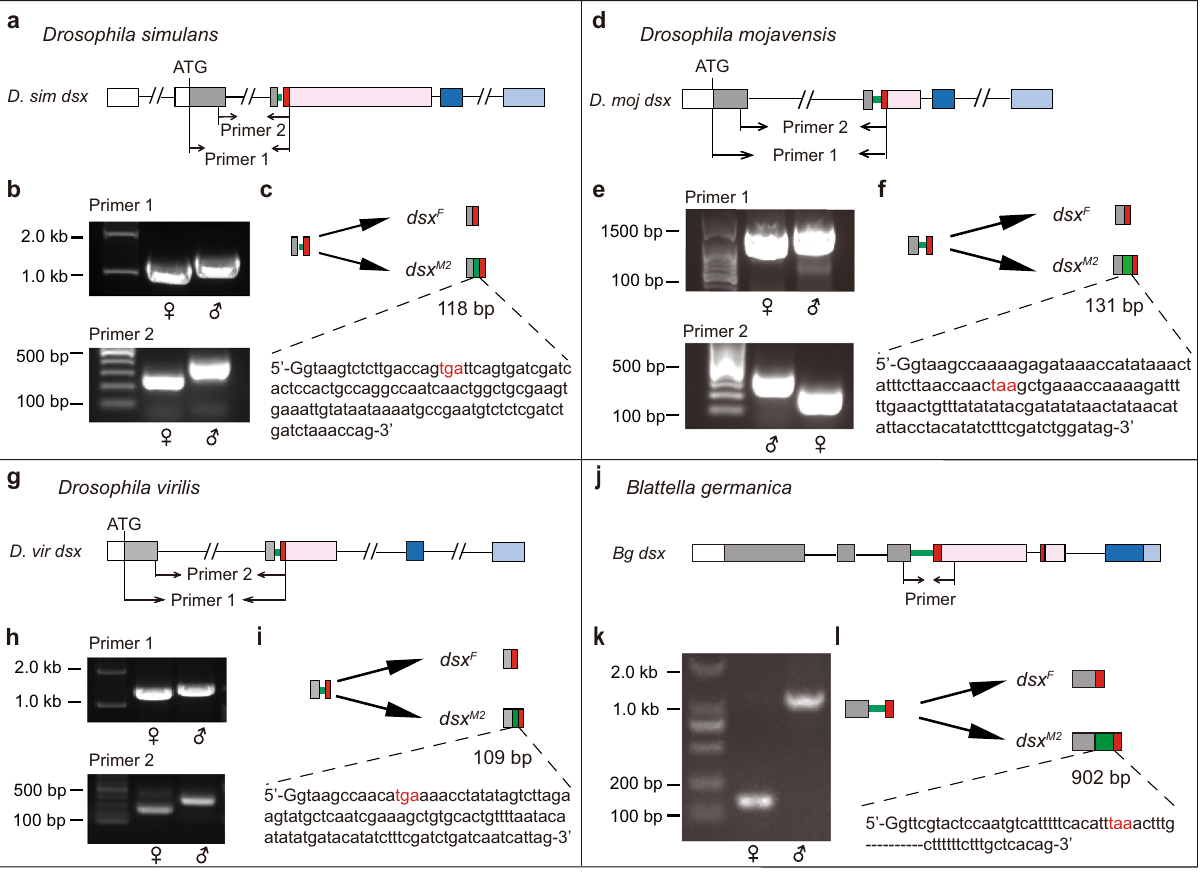
Fig. 3 Intron retention-induced sex-speci fi c splicing is widely conserved. Retention of the intron that separates the last common exon and the female- speci fi c exon generates male-speci fi c dsx M2 transcripts in D. simulans ( a – c ), D. mojavensis ( d – f ), D. virilis ( g – i ) and B. germanica ( j – l ). The dsx gene structures are illustrated in a , d , g and j . White and gray boxes indicate common 5 ’ -UTR and coding sequences respectively in both sexes. Red and pink boxes indicate coding and 3 ’ -UTR sequences of the female-speci fi c exon. Dark and light blue boxes indicate coding and 3 ’ -UTR sequences of male-speci fi c exons. The thick green line indicates the intron spliced out in the dsx F transcript and retained in the dsx M2 transcript. Primers for RT-PCR experiments ( b , e , h and k ) are indicated respectively ( a , d , g and j ). Full sequences of the retained intron of dsx M2 are indicated ( c , f and i ) except for the 902bp one in B. germanica dsx M2 ( l ). The capital letter “ G ” from the upstream exon is added in front of the intron sequence to ensure that the stop codon highlighted in red is aligned within the open reading